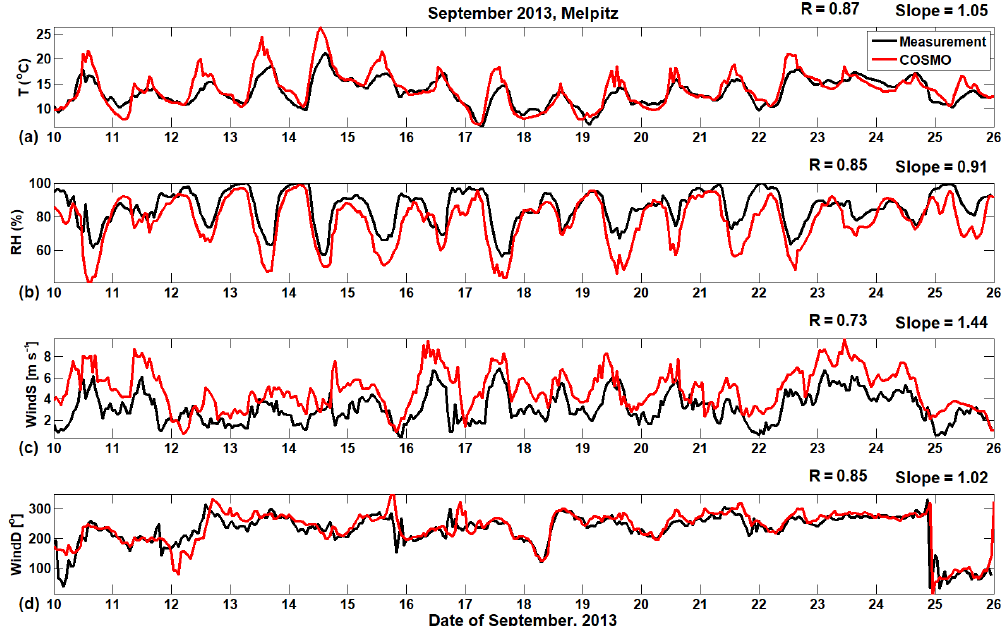
Figure 2. Comparison between modelled and measured meteorological conditions. (a) Temperature ( T ); (b) relative humidity (RH); (c) wind speed; (d) wind direction.